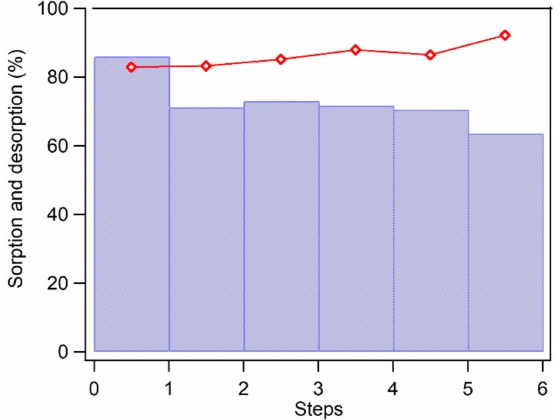
Figure 9. Carbamazepine sorption percentage by BC-Mag within consecutive six repeated steps of ethanol washing (bar graph) and the recovery of carbamazepine by ethanol as desorbant from every step (red dots and line). Experimental conditions: carbamazepine initial concentration 10 mg L − 1 , mass of BC-Mag 10 mg, solution volume 10 mL, bu ff er solution of 1 mM NaHCO 3 and 20 mM